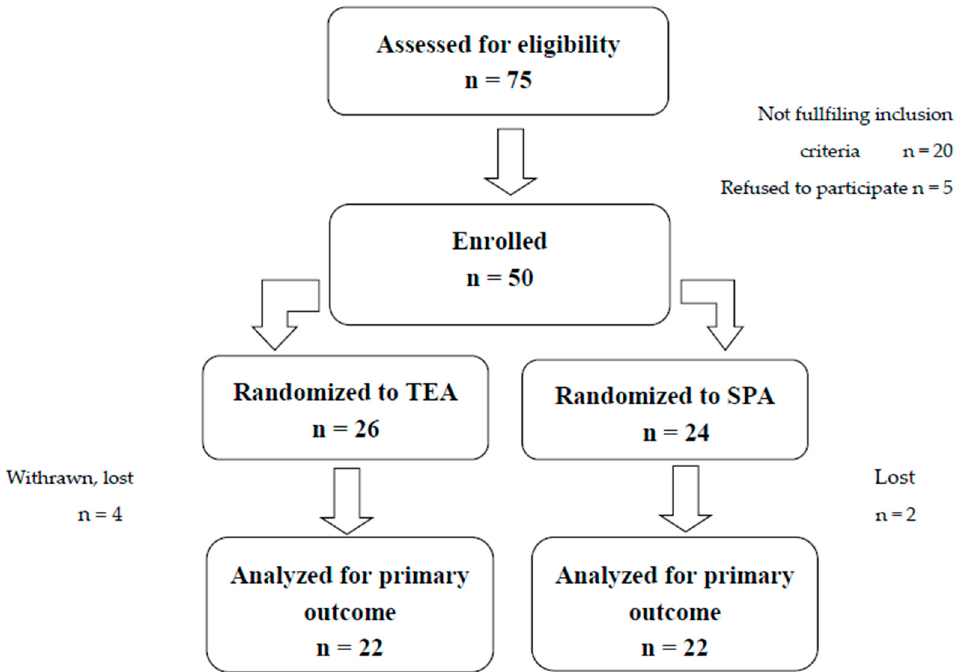
Figure 2. CONSORT flow diagram of the study. Six patients were excluded from the final analysis; TEA group—two patients withdrawn from the study, one patient lost due to an artificial removal of the catheter in the operating room, one patient excluded due to a lost blood sample. SPA group—one patient excluded due to a human error in sampling, one patient excluded because of the insufficient blood sample.